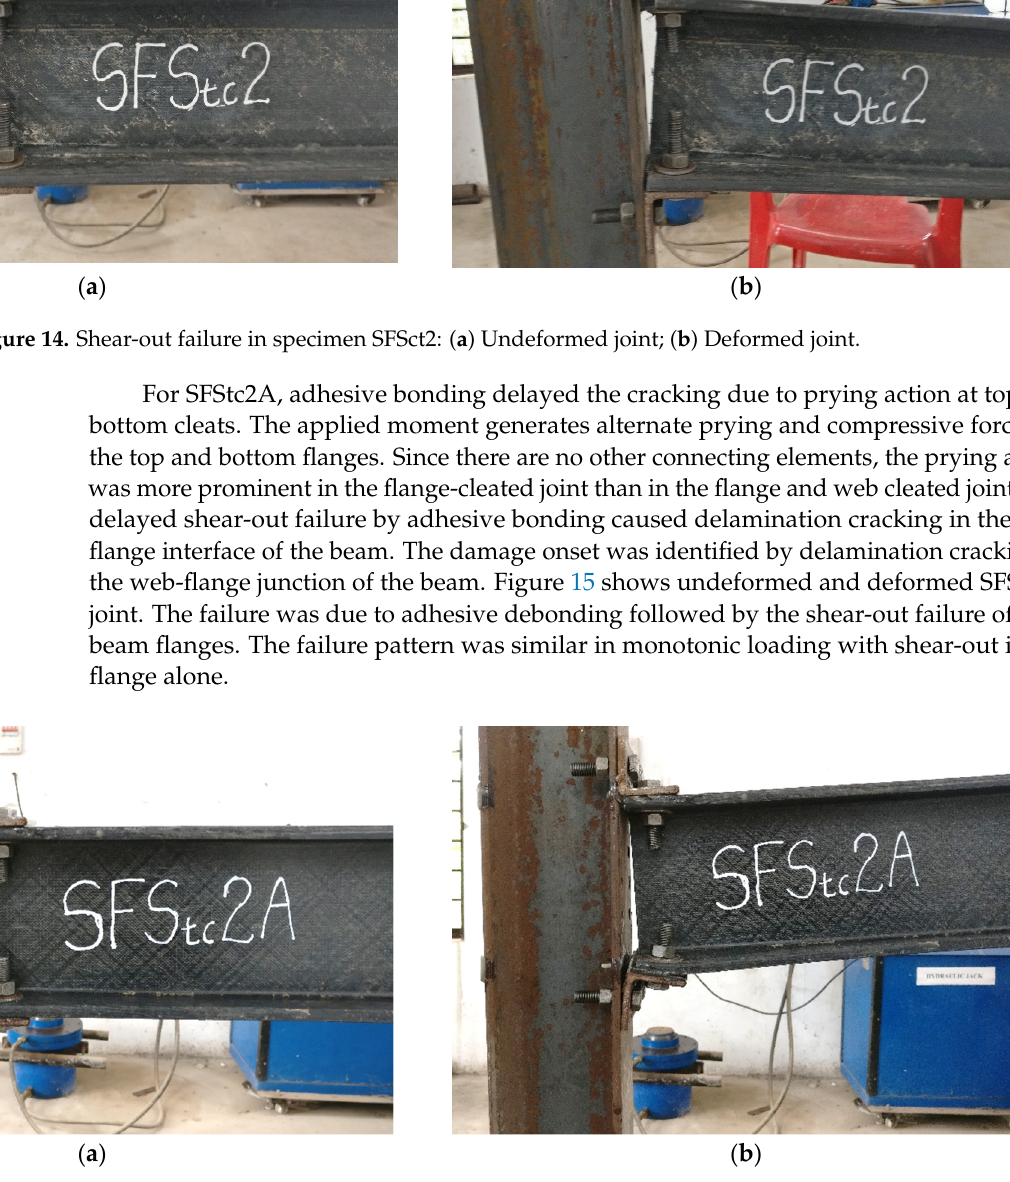
Figure 15. Adhesive debonding and shear-out failure in specimen SFSct2A: ( a ) Undeformed joint; ( b ) Deformed joint.